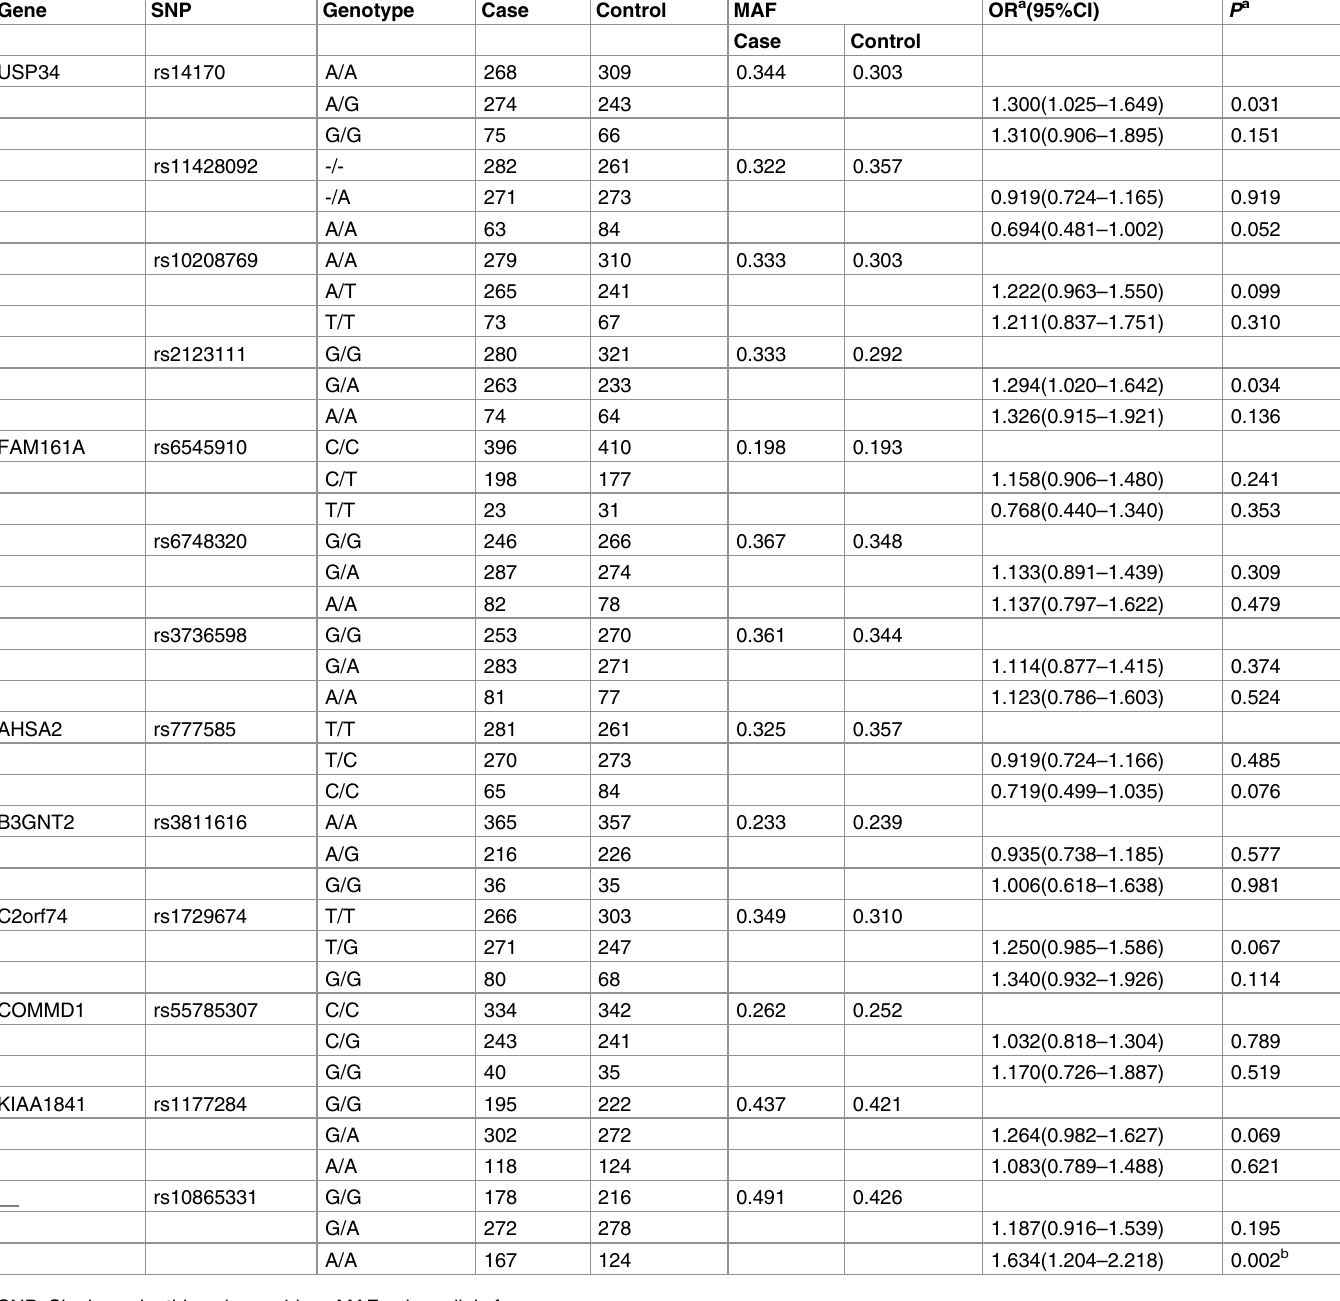
Table 2. Association of thirteen SNPs with AS in a Chinese population.